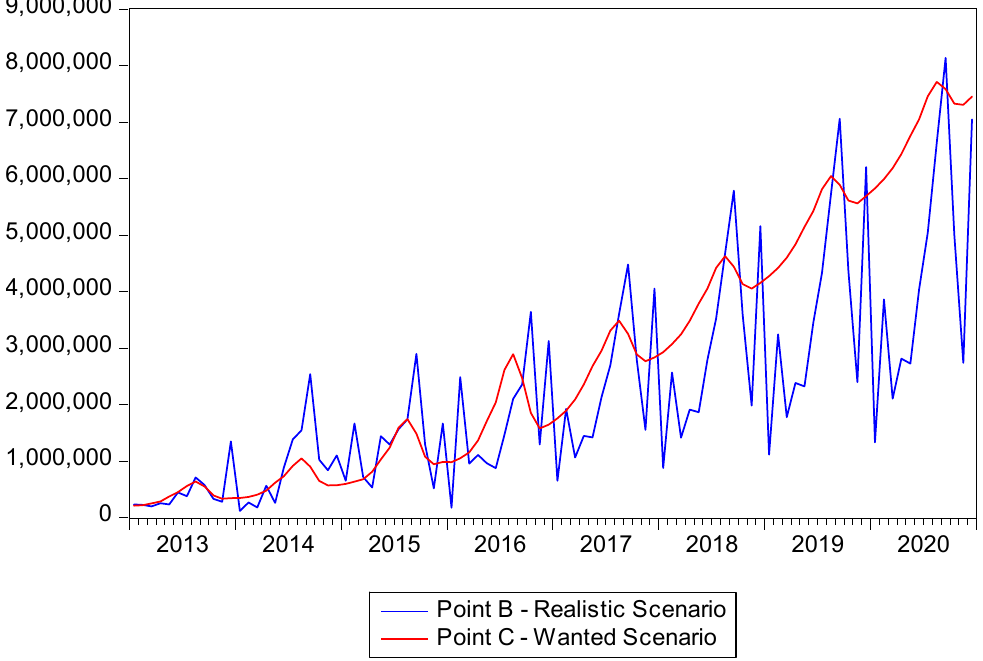
Figure 3. Forecast of casino revenues until the end of 2020. Source: Eviews 9 Output.